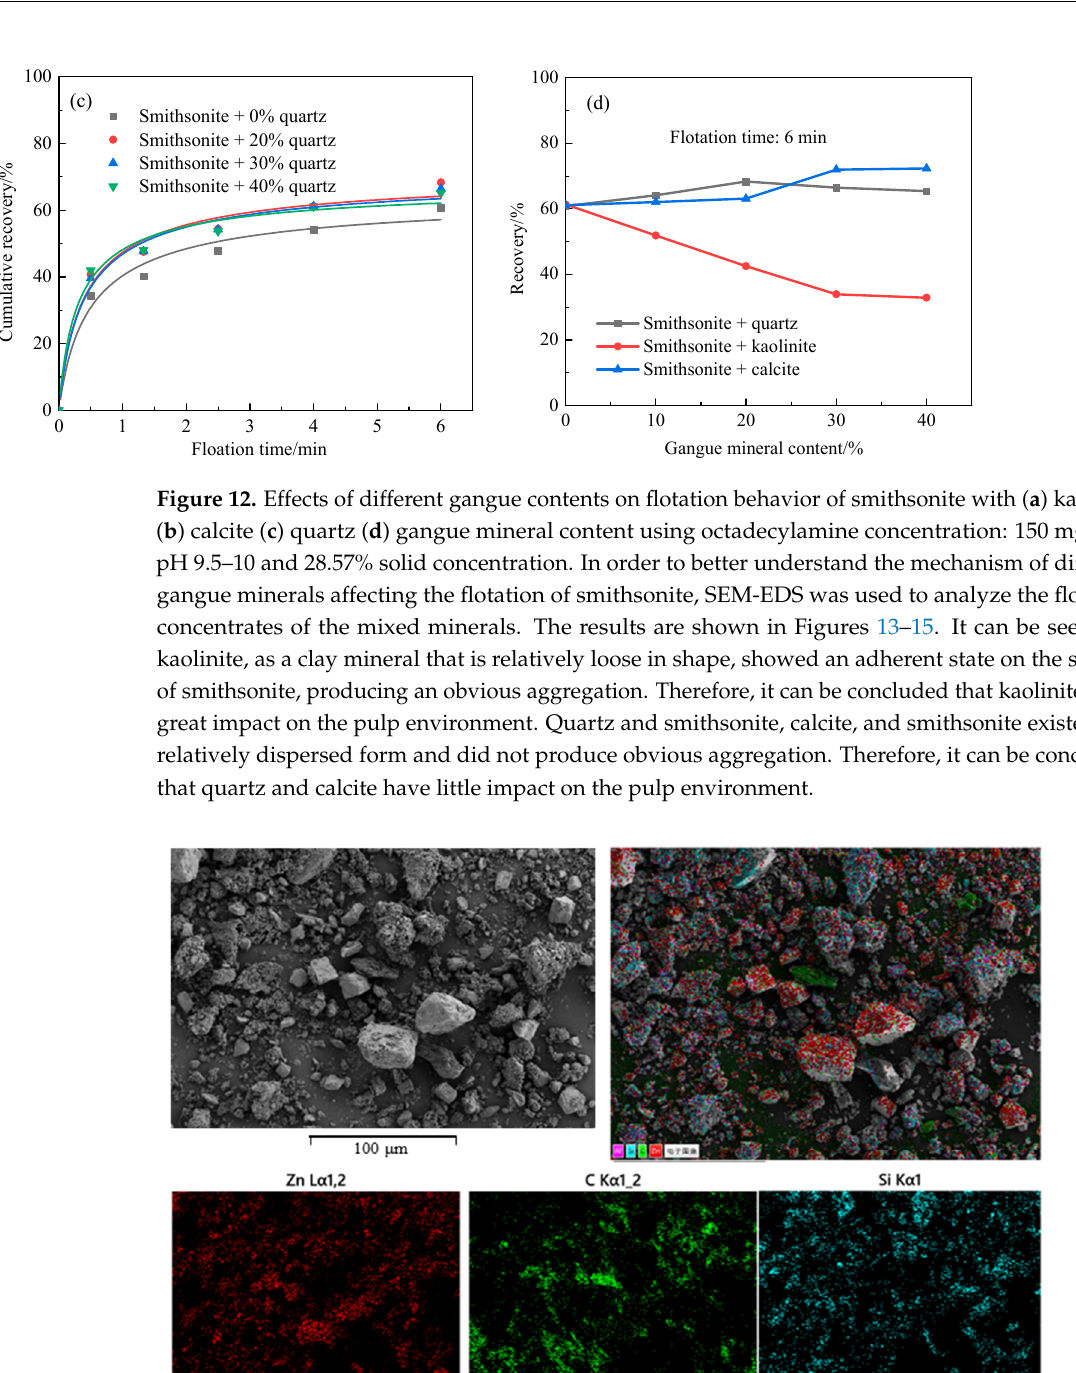
Figure 14. SEM-EDS pictures of flotation concentrate of the mixed mineral of smithsonite-calcite.